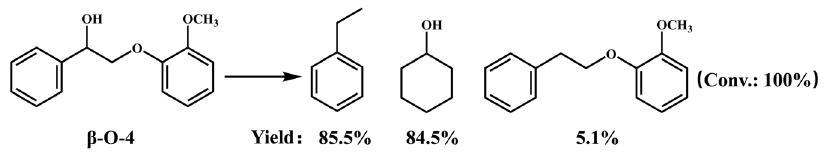
Fig. 7 Hydrogenolysis of the lignin β -O-4 model compound over the Co 3 O 4 -250 catalyst. Reaction conditions: substrate (0.2 g), catalyst (0.1 g), 1,4- dioxane (5 mL), H 2 pressure (0.5 MPa), temperature (180 °C),